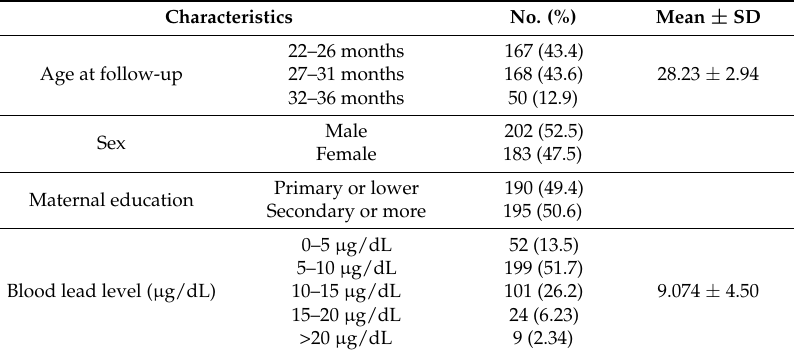
Table 1. Selected characteristics of the study population of children in Munshiganj, Bangladesh ( N =